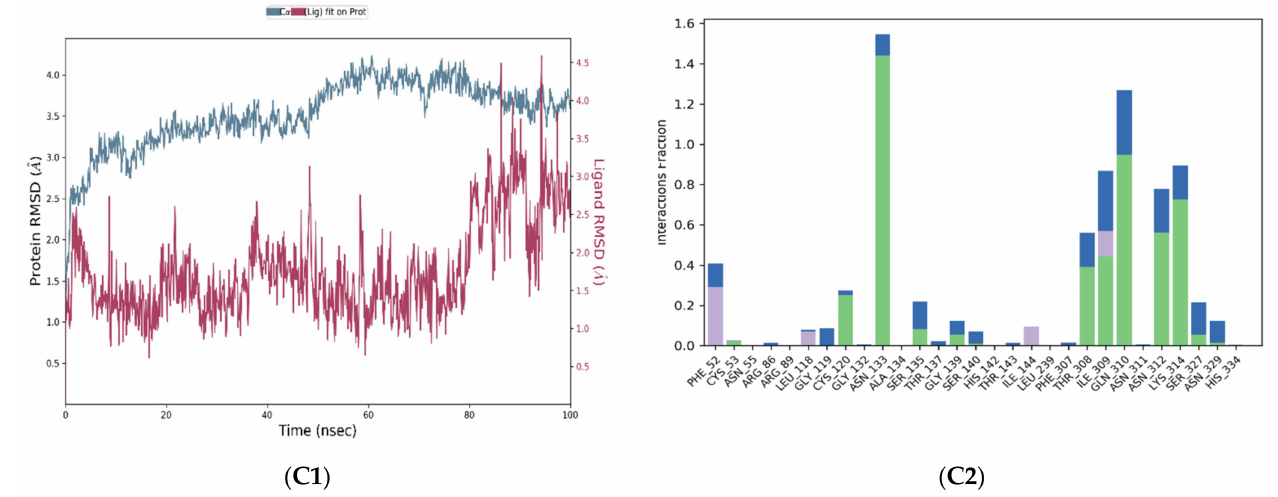
Figure 5. RMSD plot ( left ) and histogram ( right ) describing the interaction of ligands and proteins during the 100 ns simulation. The RMSD plot shows ligands in red and protein C-alpha atoms in blue; the histogram shows H-bonds (green), water bridges (blue), and hydrophobic interactions (purple). ( A ). Complex of A6R and Fludarabine, ( B ). Complex of D8L and Fludarabine, ( C ). Complex of F13L and Fludarabine.